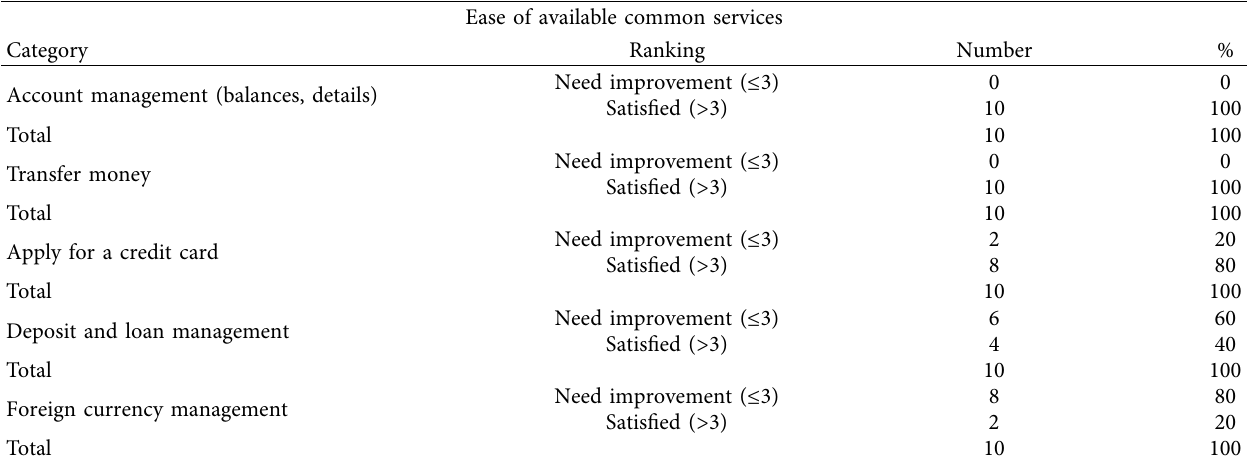
Table 8: Summary of the available common